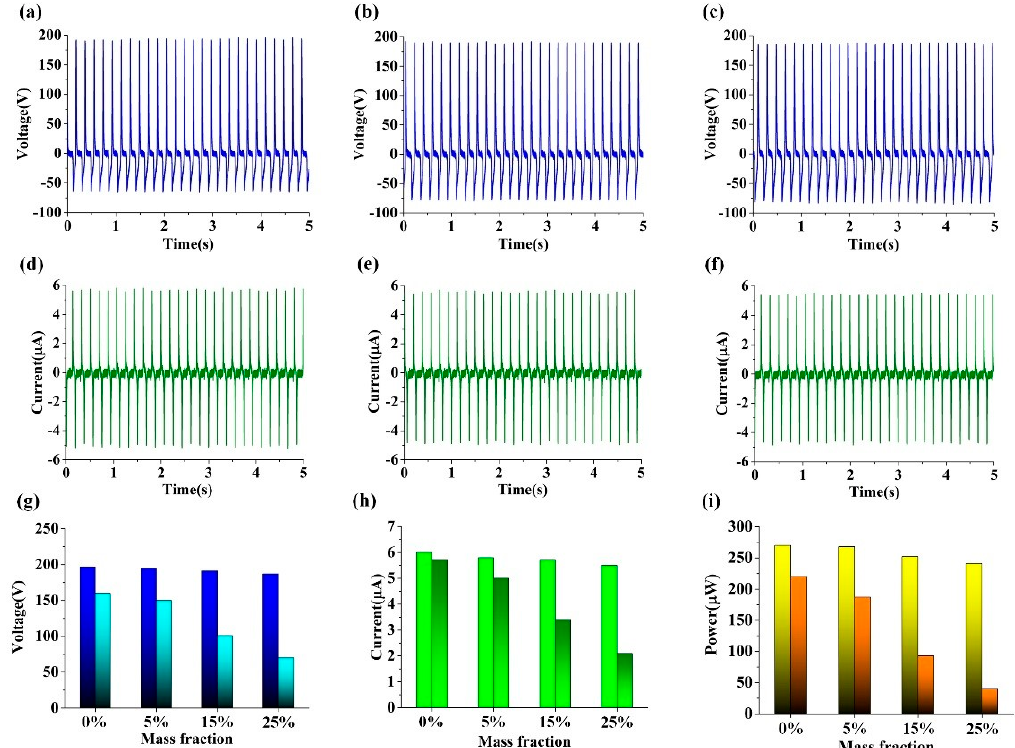
Figure 7. Electrical measurement of three CN-TENGs treated with different concentrations of sodium chloride solution. ( a , b , c ) Approximate V OC and ( d , e , f ) I SC values of the treated CN-TENGs. Comparison of the approximate V OC ( g ), I SC ( h ), and the value of max output ( i ) power for the CN-TENGs.